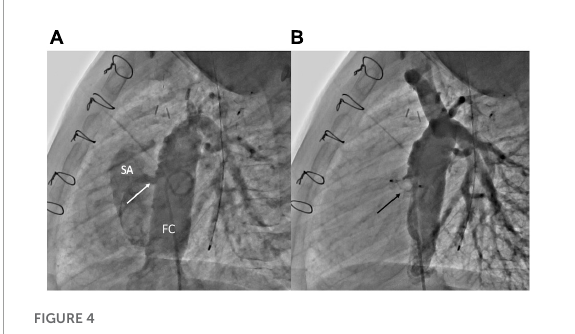
FIGURE4 Fenestration closure using vascular plugs. (A) Lateral angiogram of a Fontan conduit showing a fenestration (white arrow) between the conduit and the single atrium. (B) Lateral angiogram following fenestration closure using an Amplatzer Vascular Plug II (Abbott) (black arrow). FC, Fontan conduit; SA, single